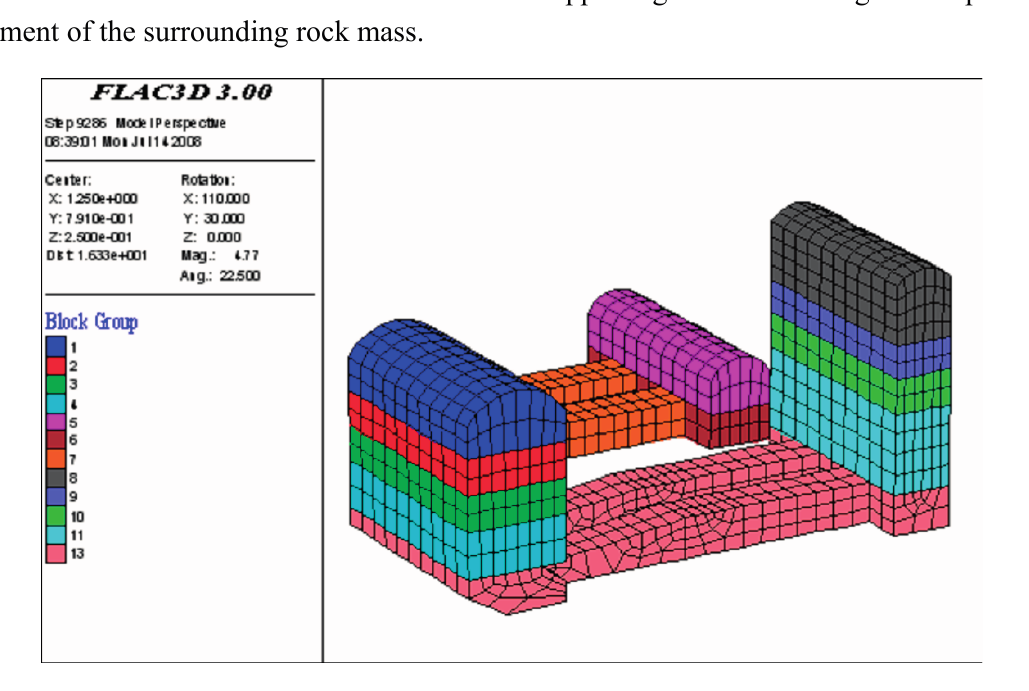
Figure 9. A 3D numerical model of the underground cavern